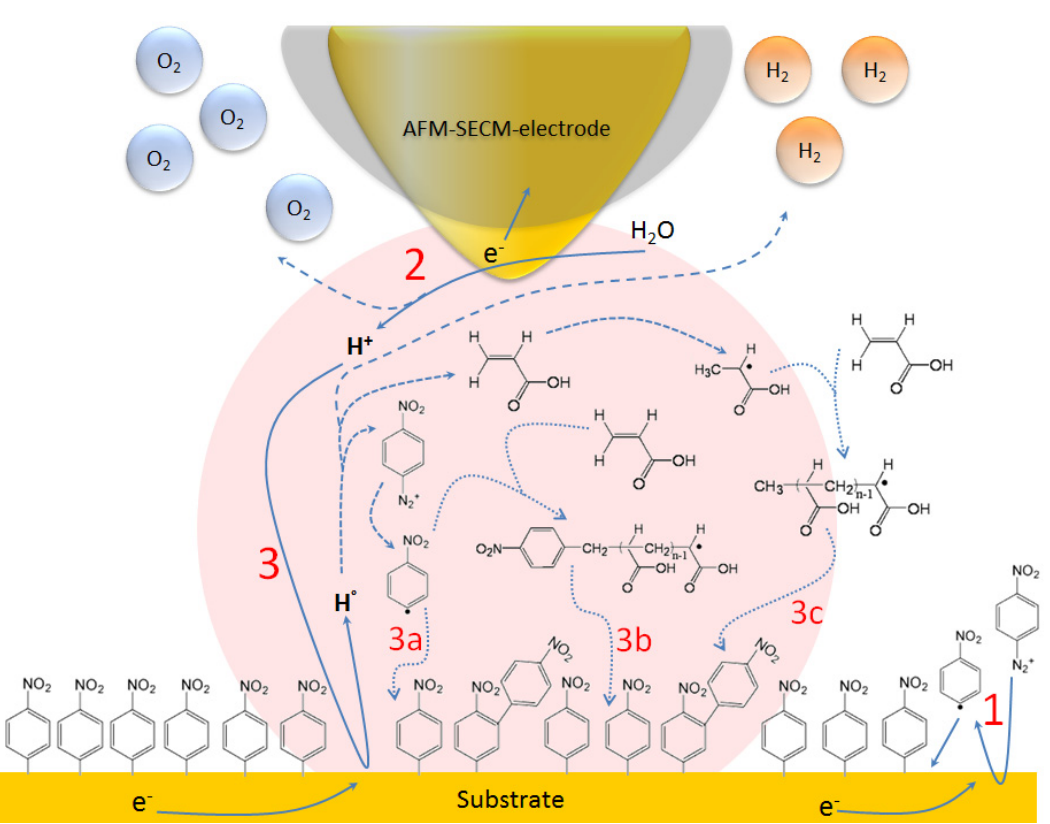
Figure 8. A simplified schematic representation of chemical and electrochemical reactions leading to the line grafting. ( 1 ) Reduction of the diazonium salt on the substrate to form a polynitrophenylene-like film; ( 2 ) Water oxidation at the AFM-SECM-electrode; ( 3 ) Concomitant reduction of protons on the substrate and formation of a localized grafted coating onto the top of the primer polynitrophenylene (PNP) film by radical reaction. ( 3a ) Formation of a phenyl radical and reaction with PNP film; ( 3b ) Phenyl radical initiates the first vinylic (plausible) radical polymerization. Reaction of the formed macroradicals with the grafted layer; ( 3c ) Formation of radical monomer, initiation of the second (plausible) vinylic radical polymerization and reaction of the formed macroradicals with the grafted